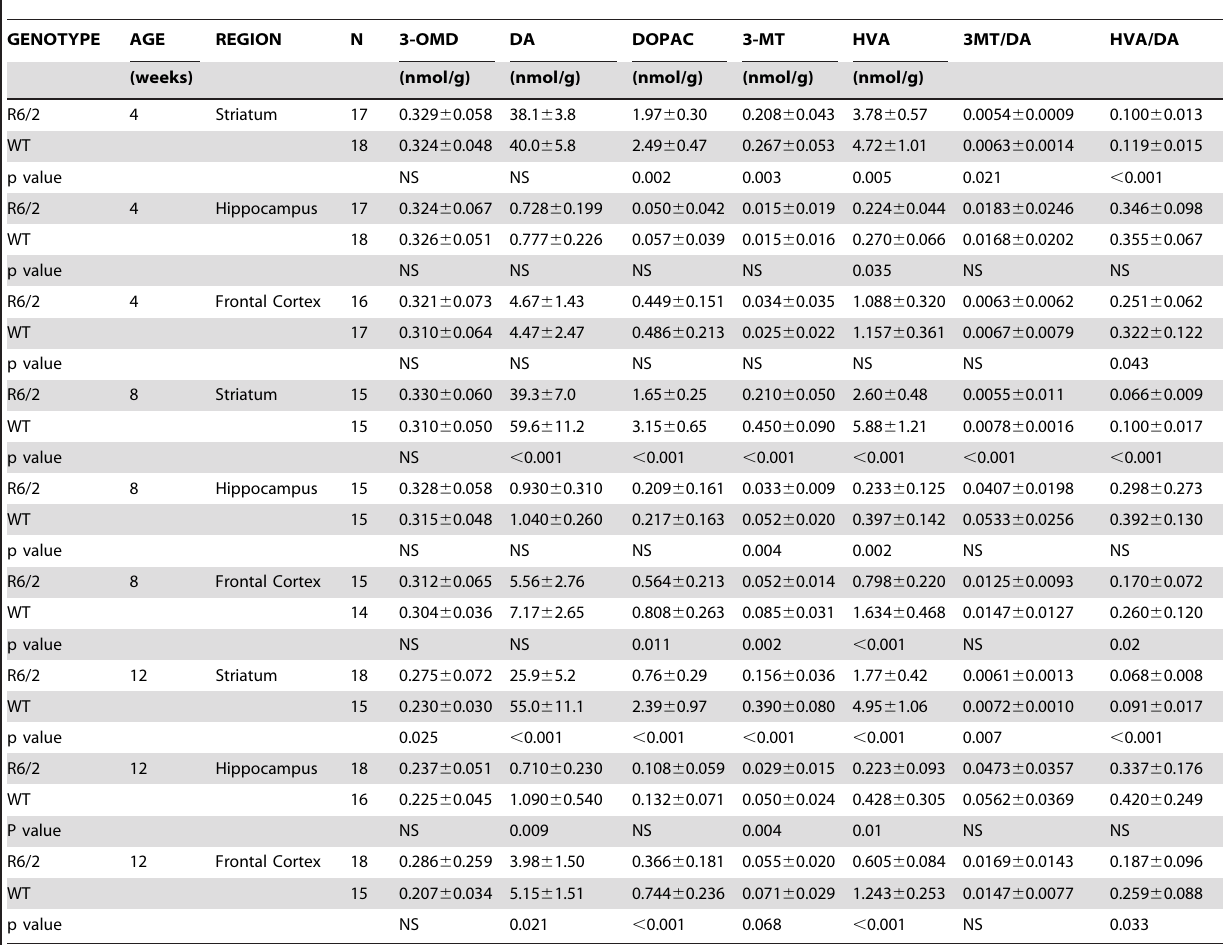
Table 1. Profile of dopamine metabolites in brain of WT and R6/2 mice at 4, 8 and 12 weeks of age.